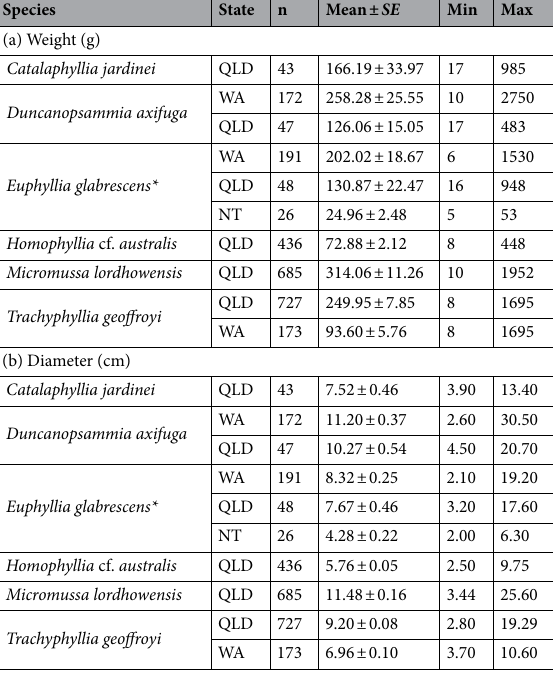
Table 1. Coral pieces used to construct size-weight models showing the state that the samples were obtained from, number (n), mean ± SE , minimum (min) and maximum (max) value of samples by (a) coral weight (g), and (b) coral diameter (cm) for each species ( Catalaphyllia jardinei , Duncanopsammia axifuga , Euphyllia glabrescens , Homophyllia cf. australis , Micromussa lordhowensis , Trachyphyllia geoffroyi ). *Some evidence to suggest E. glabrescens may represent different species across states (based on tentacle morphology, tank compatibility, planulation time, and